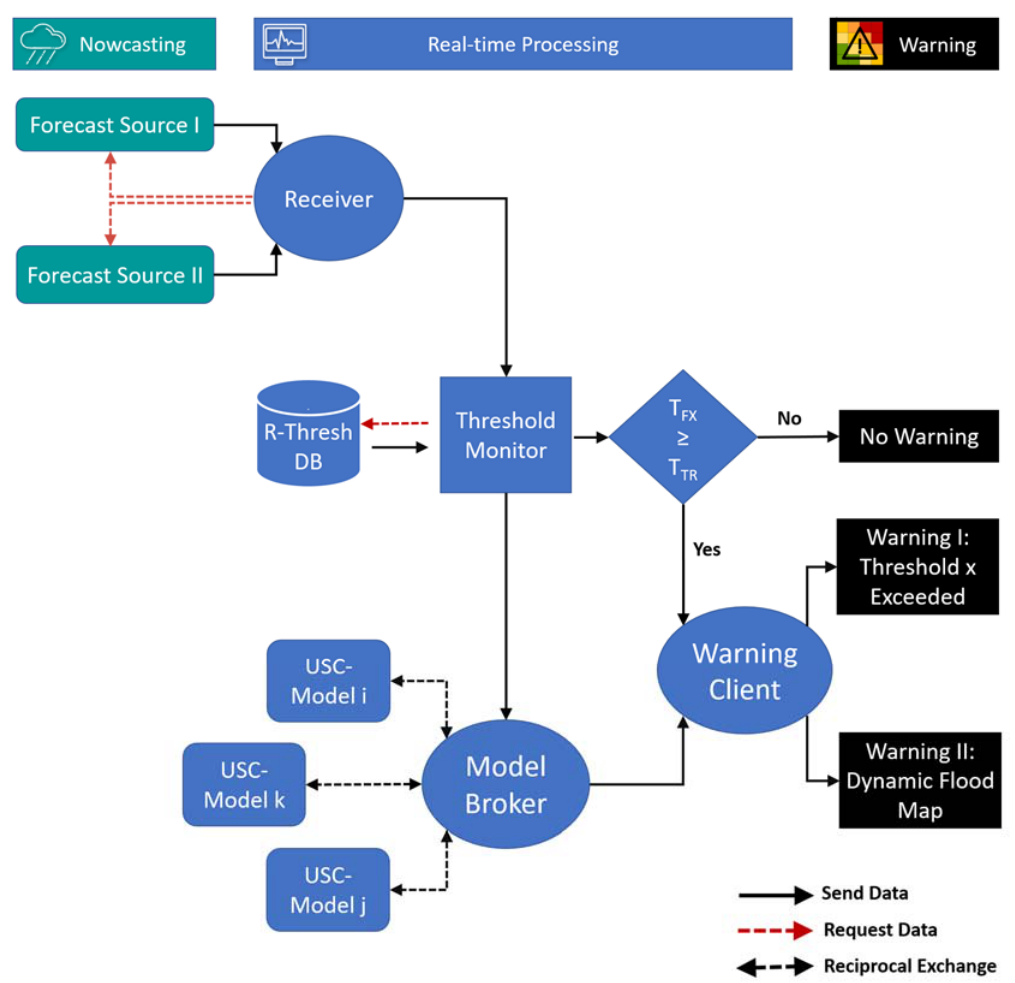
Figure 3. Process schema of the pluvial flood alarm operator (PFA-Operator) including the main components and process steps. The hydrodynamic flood forecasts are activated once the R-threshold is exceeded.